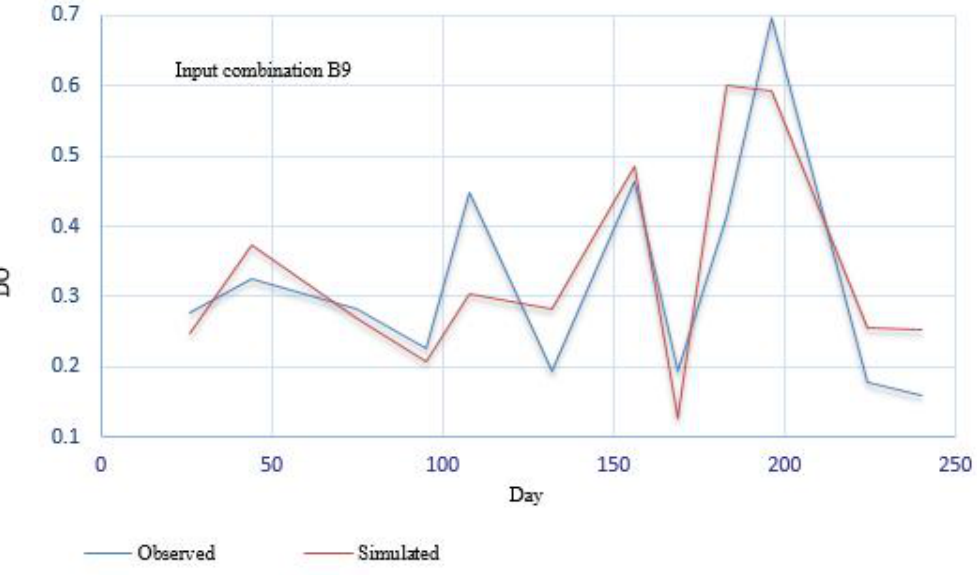
Fig. 5: Daily observed comparison of and simulated DO